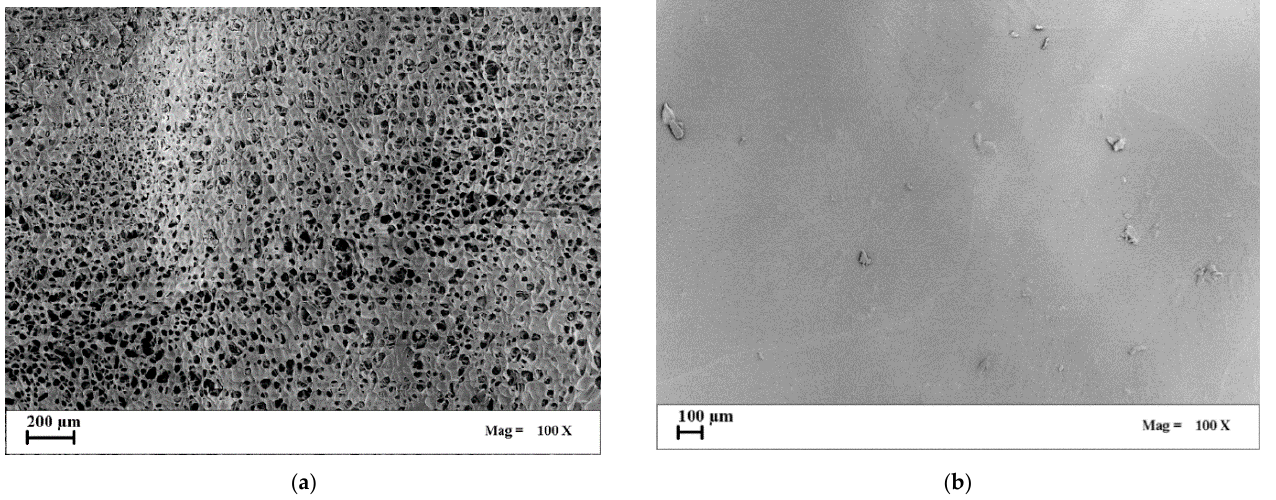
Figure 1. SEM images of cryogels surface obtained by a fast ‐ cooling step: ( a ) 1 wt% agarose; ( b ) 8 wt% agarose.